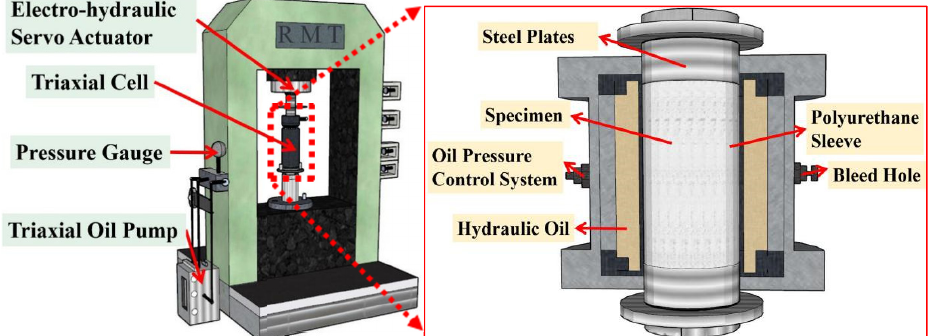
Figure 4. Loading